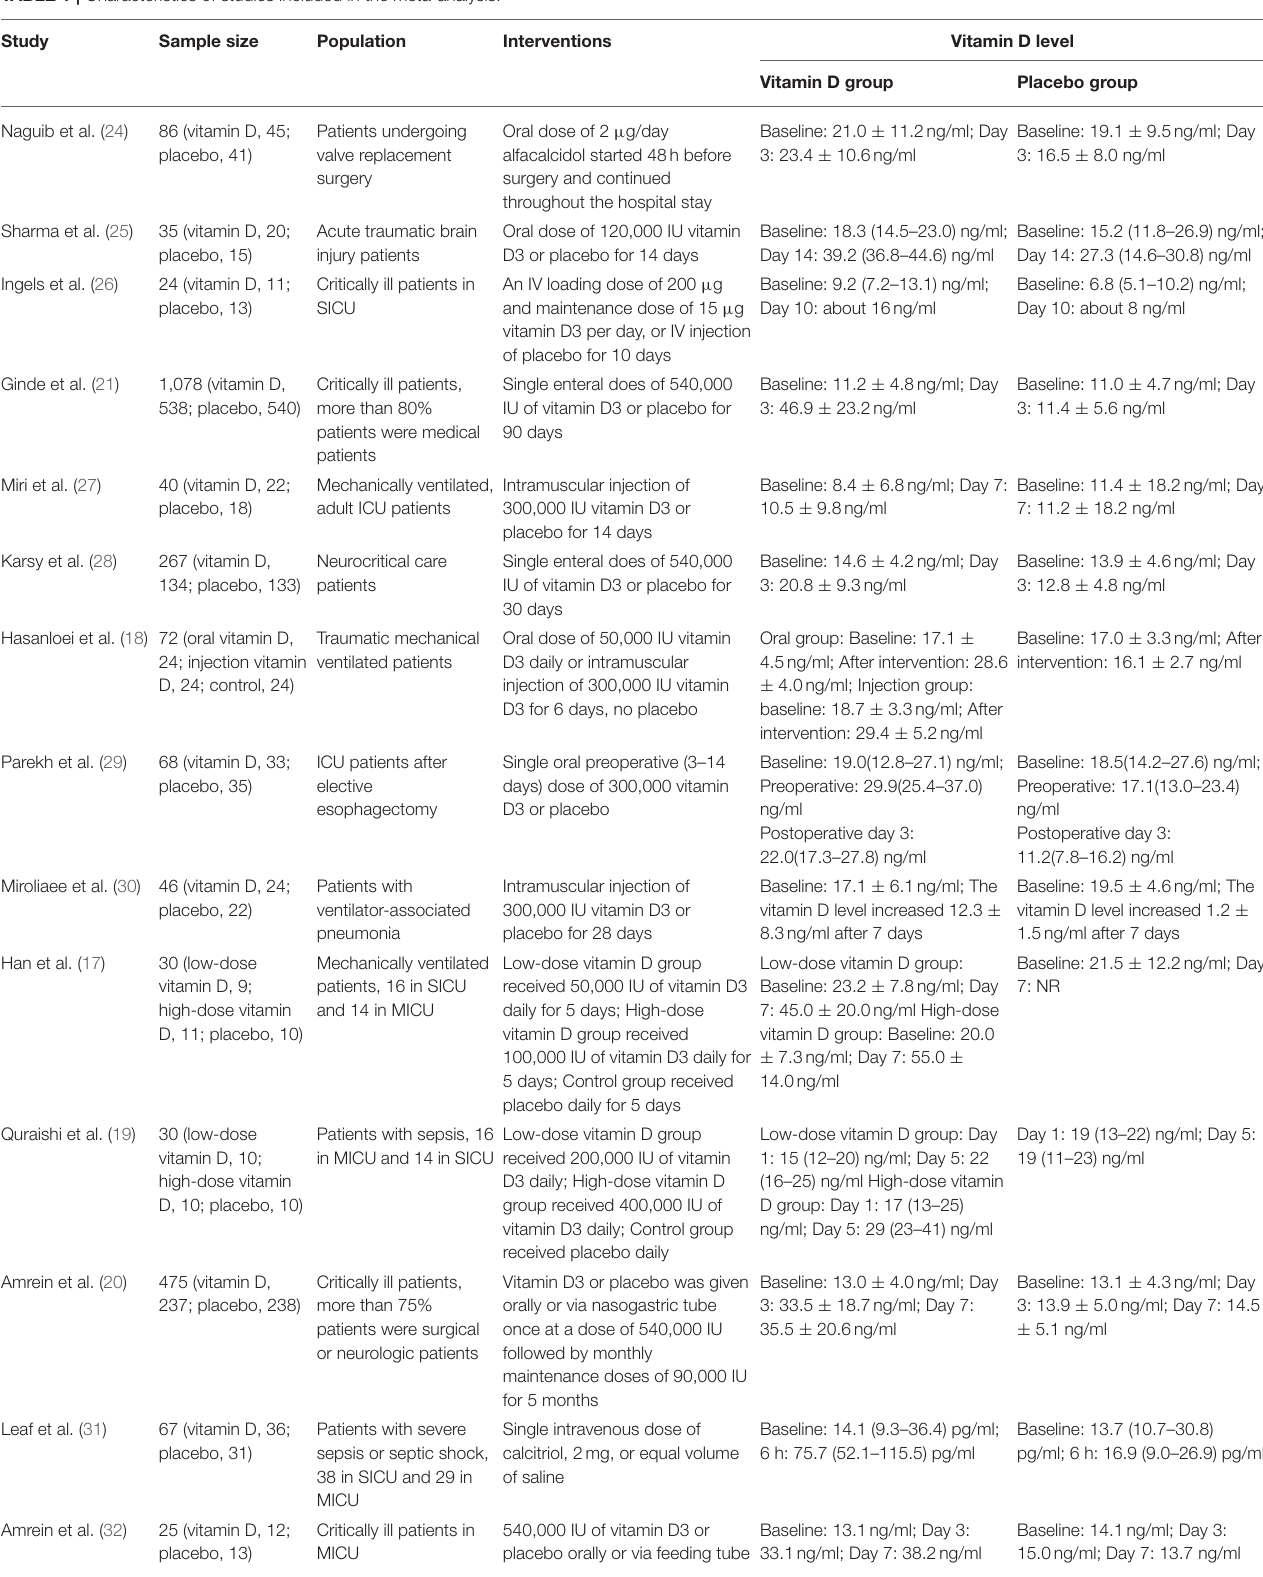
TABLE 1 | Characteristics of studies included in the meta-analysis. Study Vitamin D level